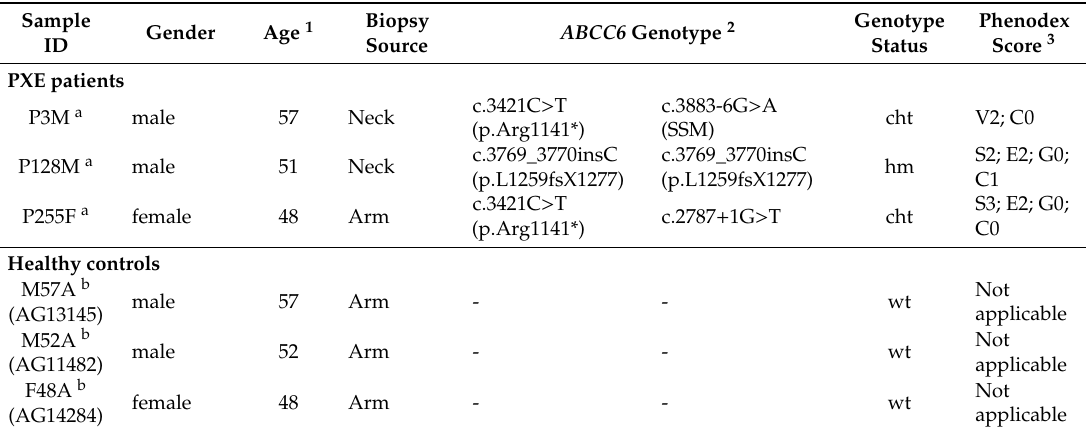
Table 2. Characteristics of fibroblasts